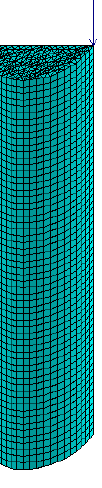
Figure 4. Calculation scheme in LIRA SAPR software.